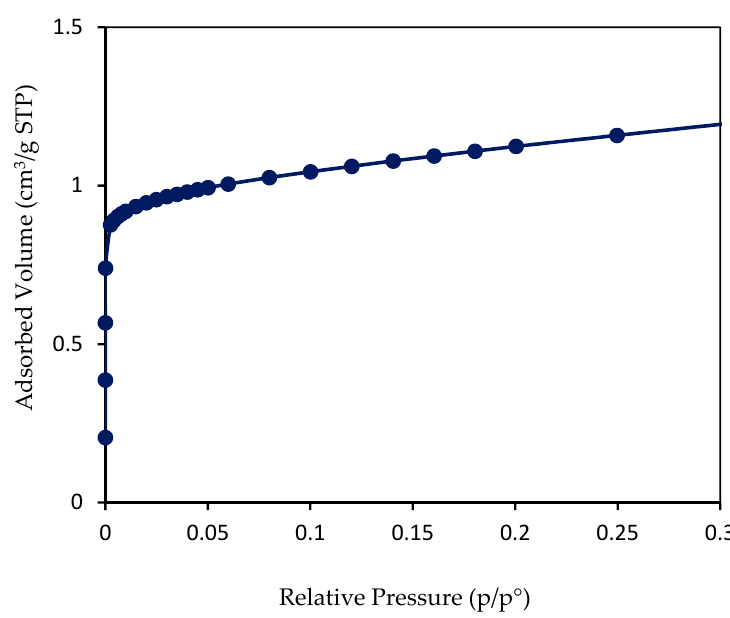
Figure 3. Nitrogen adsorption isotherm at − 196 ◦ C of the FAU-type membrane after 24 h of thermal treatment. The adsorbed volume is expressed in cm 3 per gram of the total sample, including the mass of the alumina